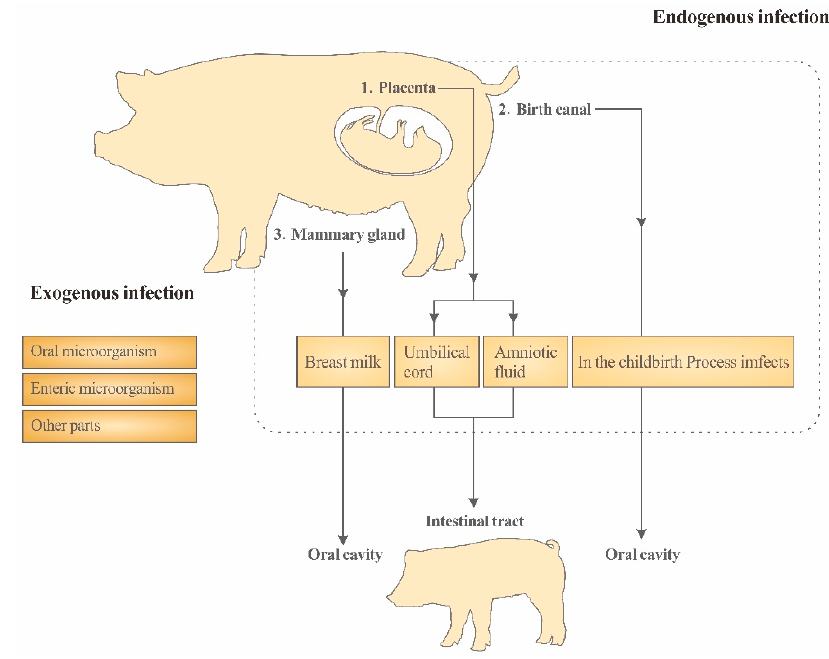
Figure 1. In the childbirth Process imfects to In the childbirth process infects.